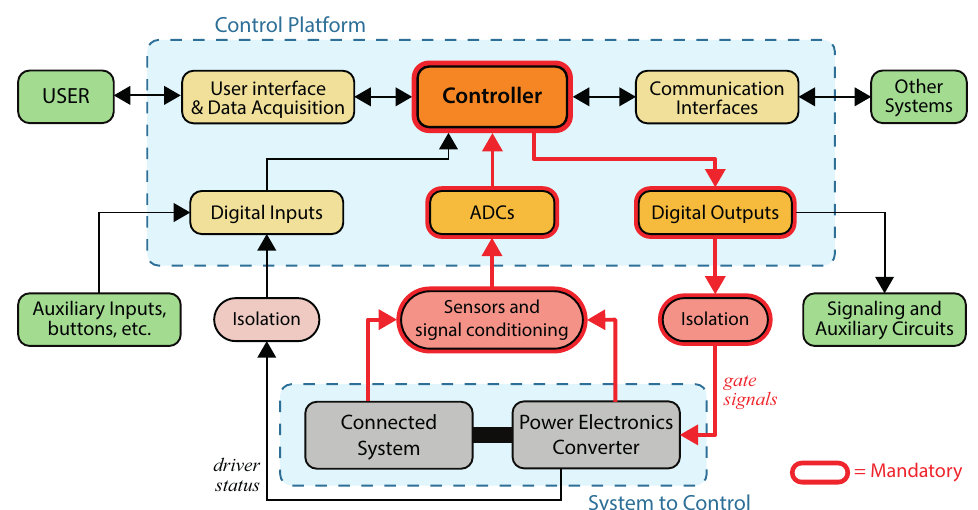
Figure 1. Most common controller interfaces and peripheral hardware needed for power electronics